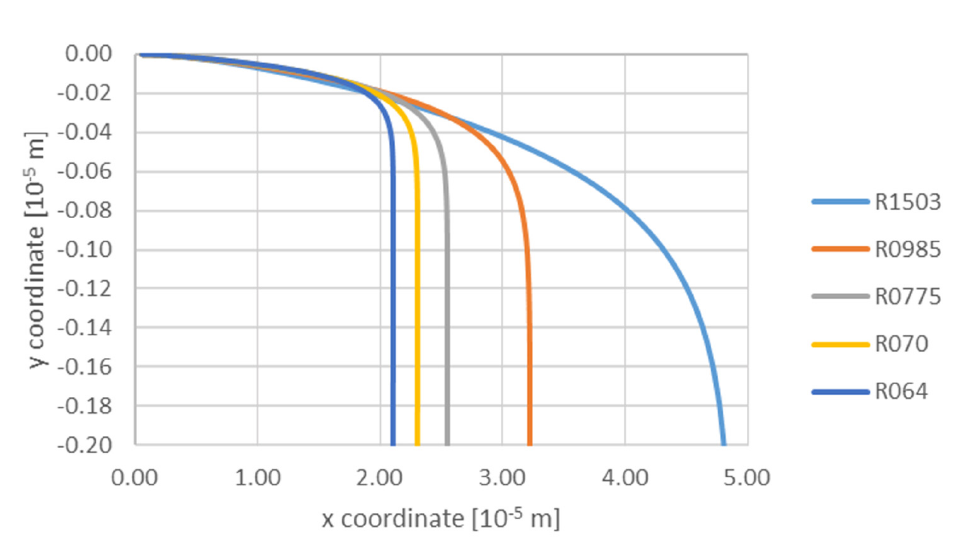
Figure 3. Analysis of influence of TiC particle size on the trajectory at a constant gradient 0.00001 m/s and viscosity 0.0013 Pa·s: R064—6.40 × 10 − 8 m; R070—7.00 × 10 − 8 m; R0775—7.75 × 10 − 8 m; R0985—9.85 × 10 − 8 m; R1503—15.03 × 10 − 8 m.